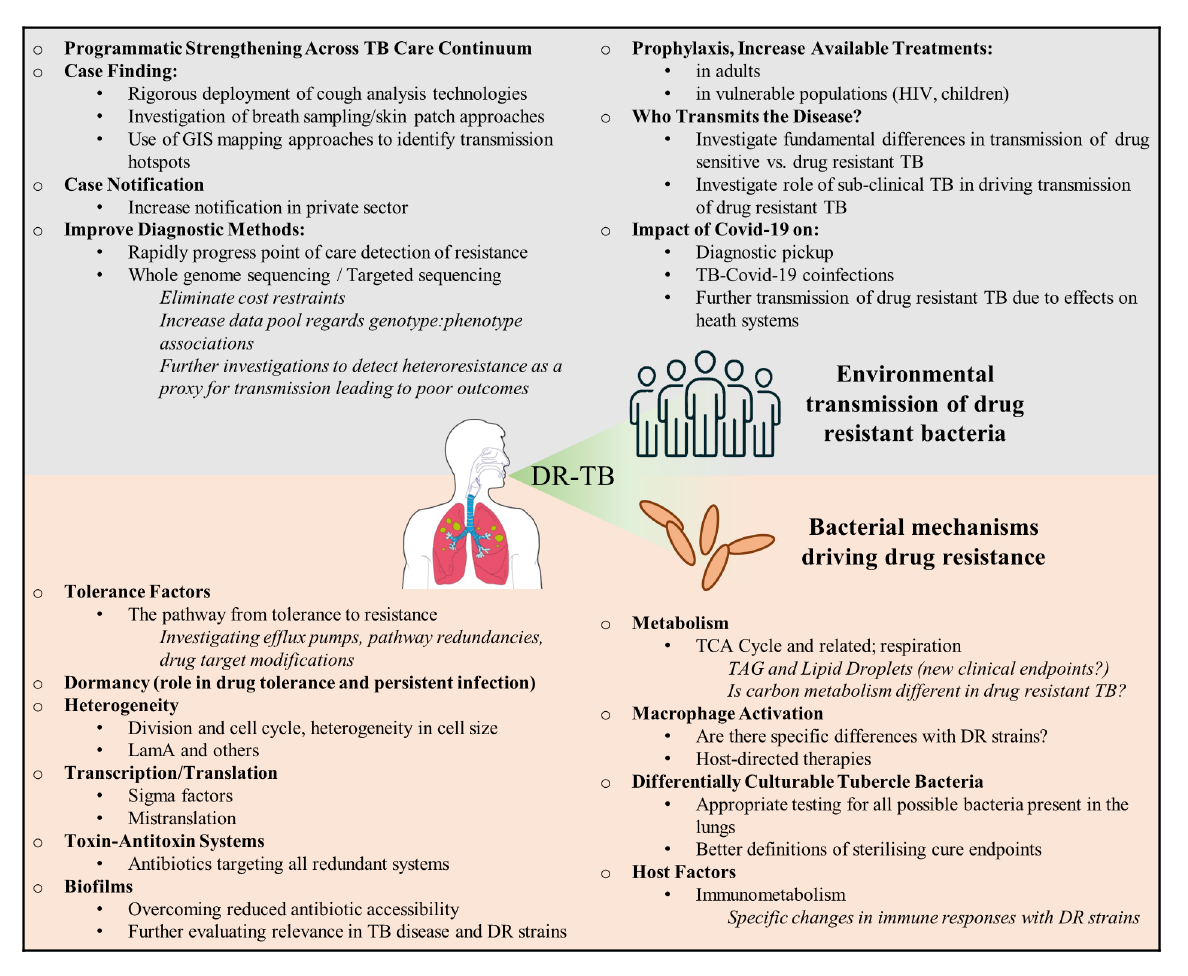
FIGURE 1 Drivers of drug resistance in TB. Key issues that need to be addressed in the fi ght against transmitted and acquired drug resistance. These primarily relate to strengthening health care systems to understanding how drug resistance